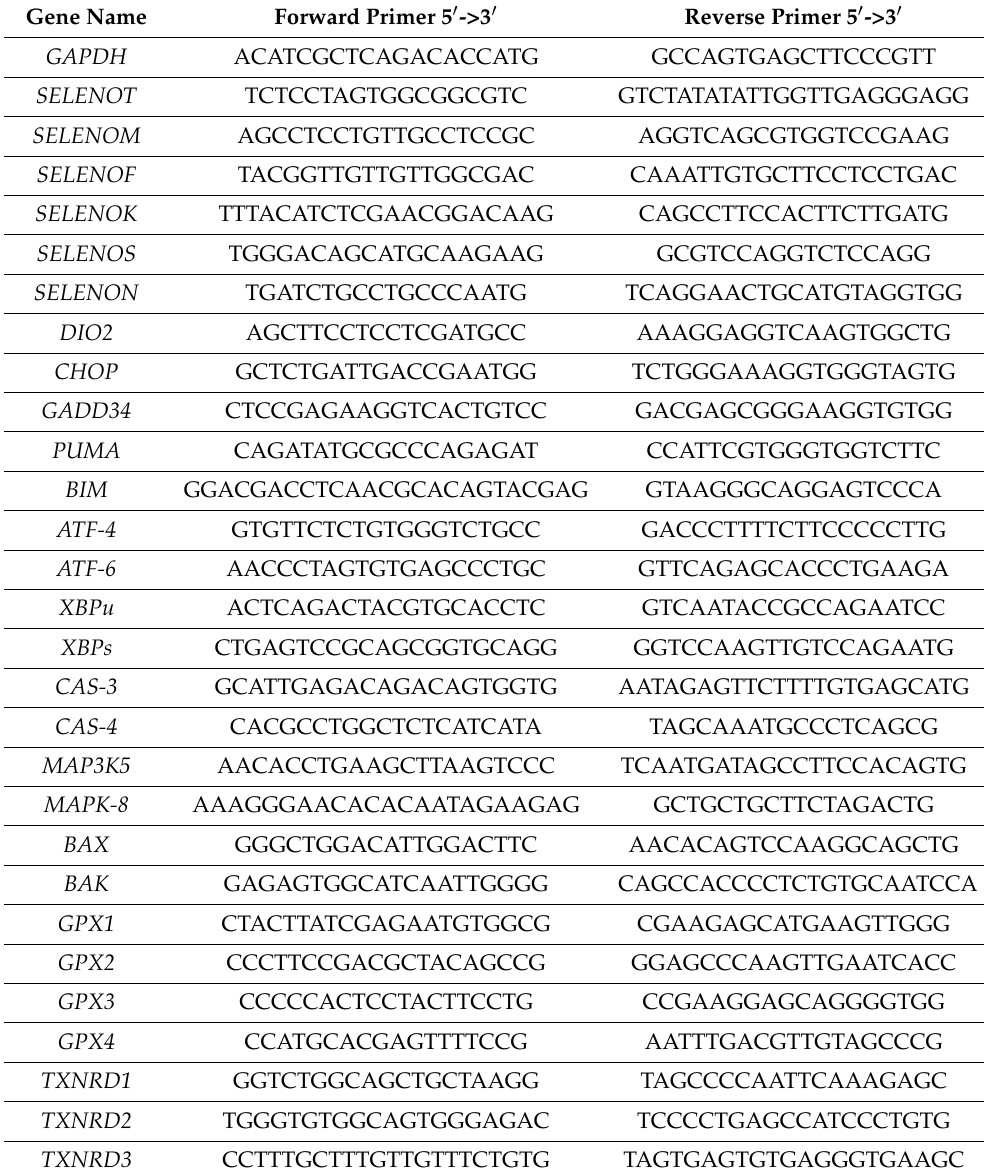
Table 1. Primers for Real-time